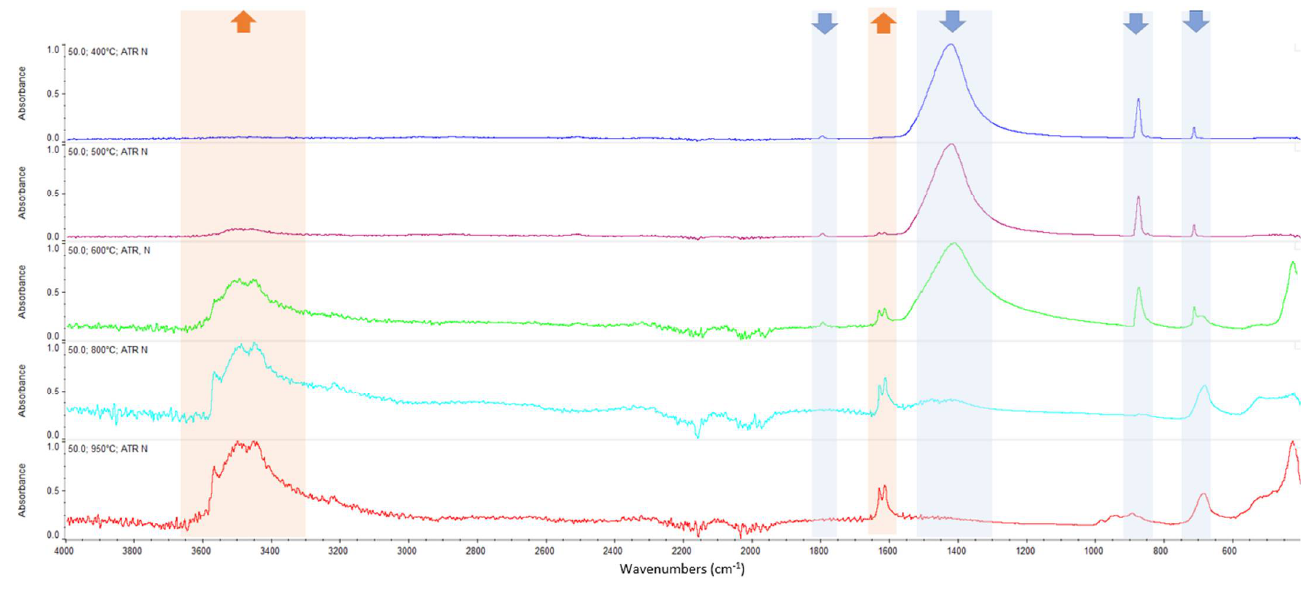
Figure A1. FTIR spectra of ashes of F50.0 at F950 °C (red), at 800 °C (light blue), at 600 °C (green), at 500 °C (purple), at 400 °C (blue).